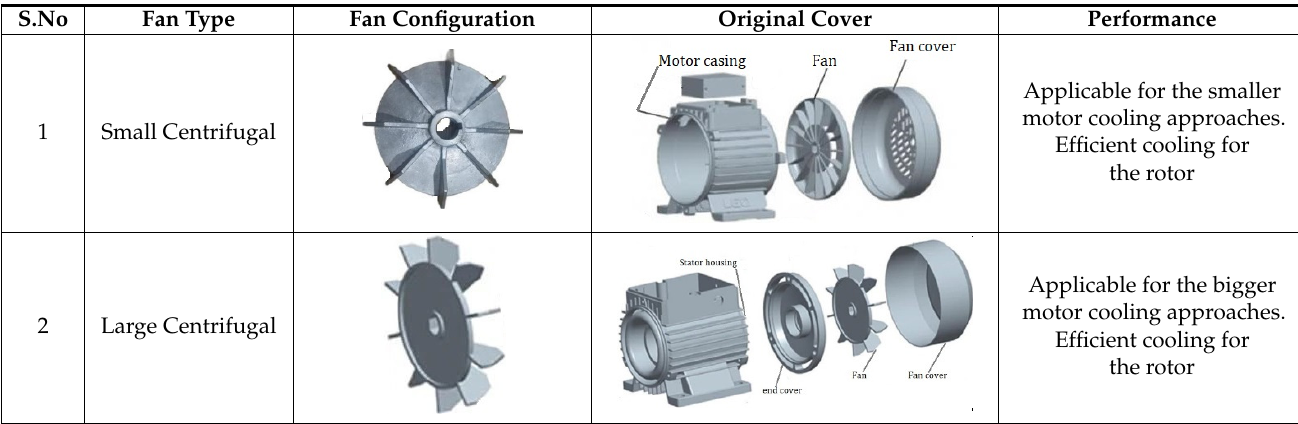
Table 4. Fan designs and the respective cover